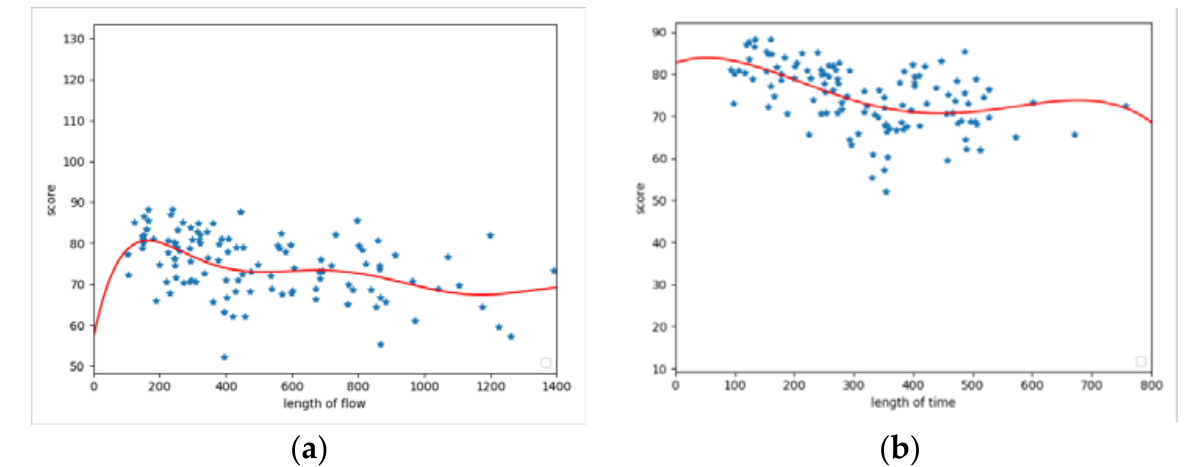
Figure 5. Regression model of non-directional online behavior and score. ( a ) Flow-score quartic polynomial regression model. ( b ) Time-score cubic polynomial regression model.